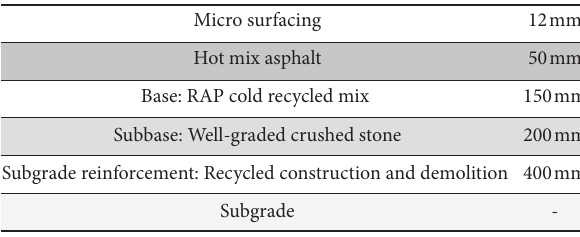
Figure 6: Designed pavement structure for the trial